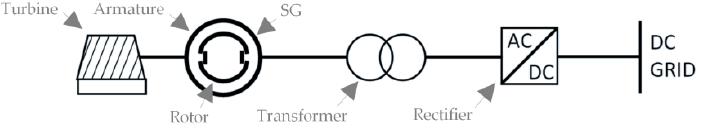
Figure 4. Connection to a HVDC system.